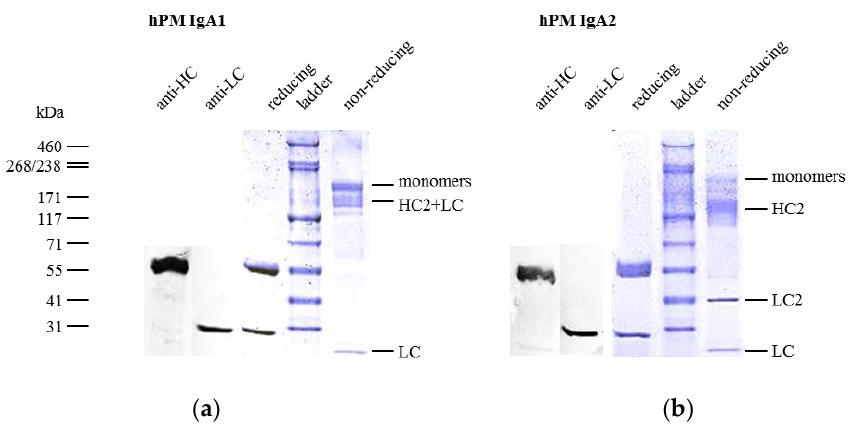
Figure 3. Purity assessment and comparison of affinity purified IgA1 ( a ) and IgA2 ( b ) by sodium dodecyl sulfate polyacrylamide gel electrophoresis (SDS-PAGE) and Western blots. Antibodies were analyzed using 4%–15% gradient gels; in reducing conditions, only bands corresponding to the size of heavy chain (HC) and light chain (LC) were detected. Identities of bands in reducing conditions were confirmed by anti-HC and anti-LC Western blots (two left lanes). In non-reducing conditions, IgA1 antibodies showed a major band corresponding to monomers (HC2 + LC2) and minor bands for free LC and monomers lacking one LC (HC2 + LC). In contrast, IgA2 antibodies dissociated mainly in HC and LC dimers (HC2 and LC2, respectively) and LC. Bands with less intensity were detected, which corresponded to the size of IgA2 monomers or IgA2 monomers lacking one LC.